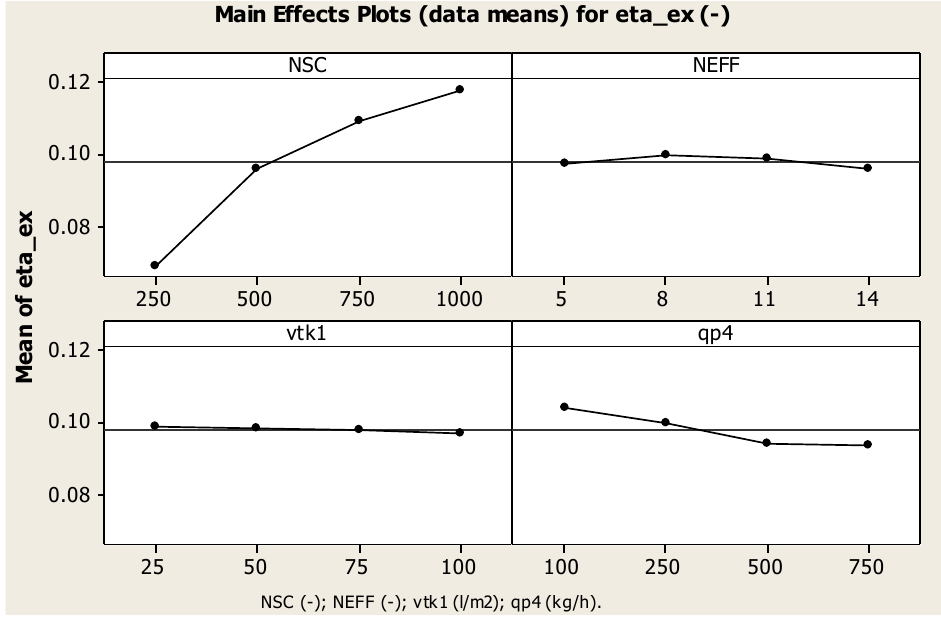
Figure 9. Main effects plots for η ex